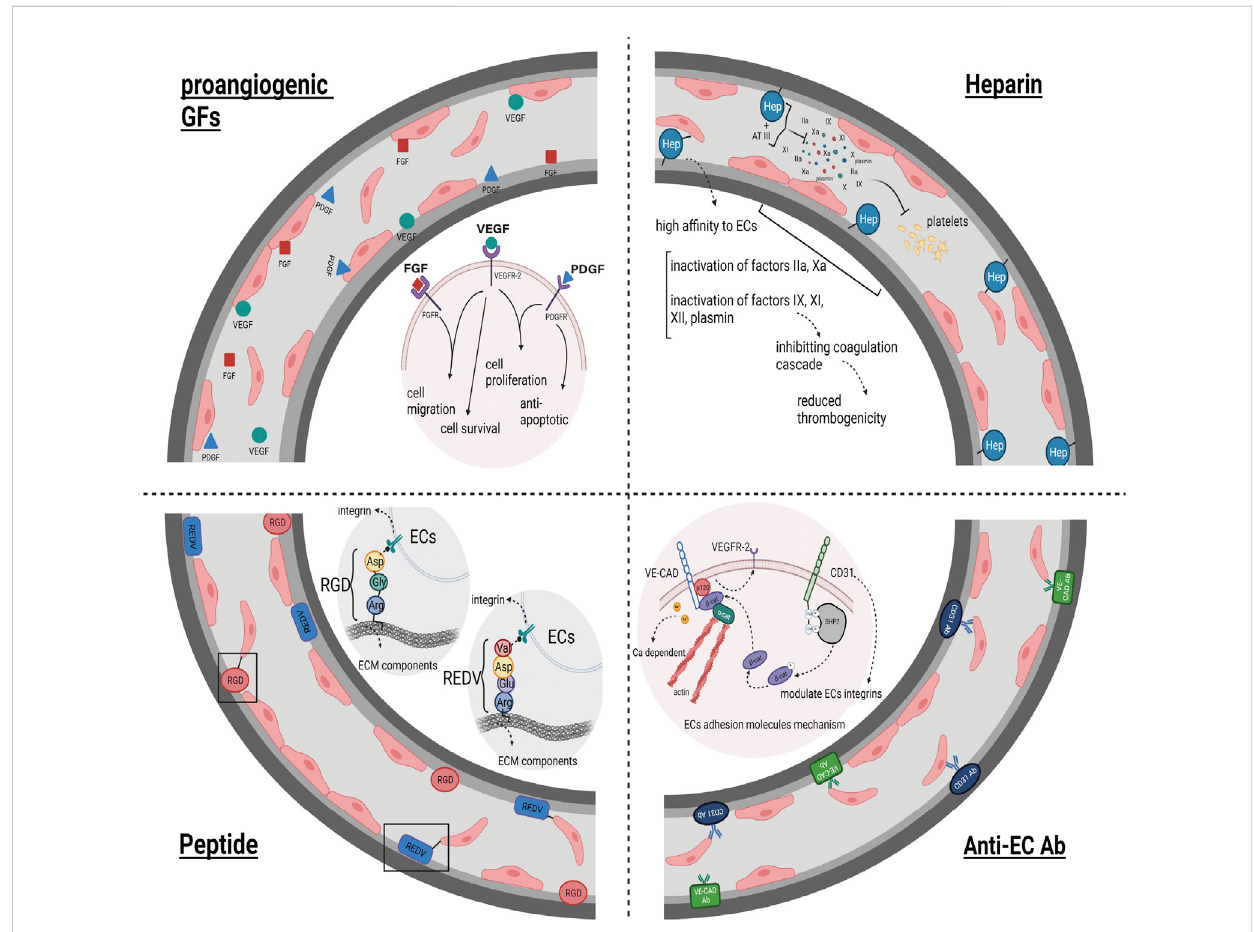
FIGURE 3 Surface Modi fi cation impact on Re-endothelialization: This fi gure illustrates the effectiveness of acellular structures surface modi fi cation on the result of endothelializationand ECs coverageof acellular vessels. Heparin biofunctionalization, as one ofthe ways to modify the acellular surfaces due to its high af fi nity to ECs and to disrupt the coagulation cascade and prevent clot formation in the vessels, leads to the endothelialization of the acellular vascular network. Anti-ECs Abs, as well as peptides possessing a recognition site for ECs, bind to their receptors present on ECs, subsequently increasing the cell attachment to the vascular scaffold and improving the endothelialization outcome. The utilization of proangiogenic GFs as another factor utilized in the fi eld of surface modi fi cation of acellular structures leads to an increase in re-endothelialization and much more complete vascular ECs coverage by stimulating and increasing cell migration, cell proliferation, cell survival, and anti-apoptotic